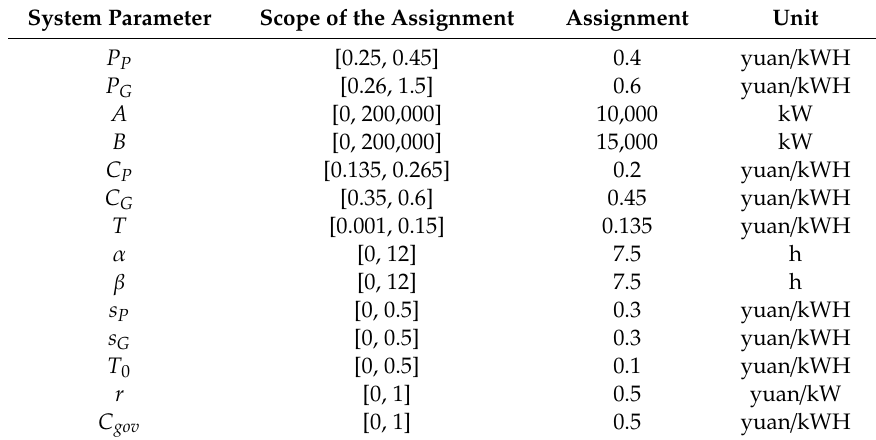
Table 5. Reference range for the initial assignment of system parameters.